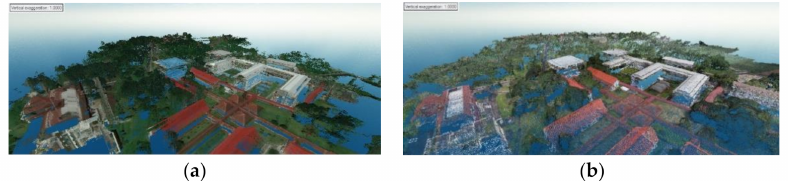
Figure 2. The point clouds data generated by ( a ) LiDAR and ( b )